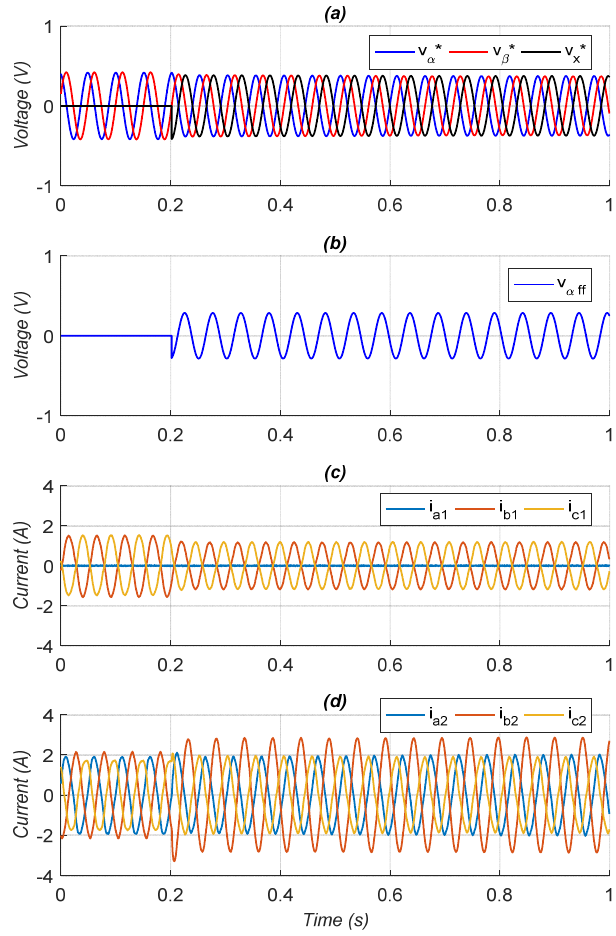
Figure 10. Postfault experimental result for the symmetrical six-phase IM drive with feedforward